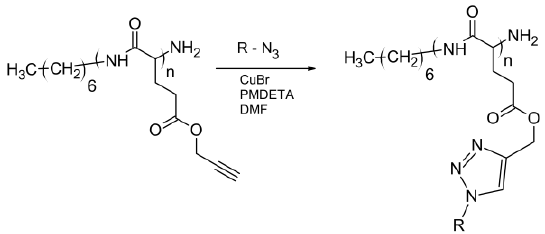
Figure 10. Synthesis of biomimetic polypeptides by ROP γ-propargyl-L-glutamate N-carboxyanhy- dride and click reactions - based on